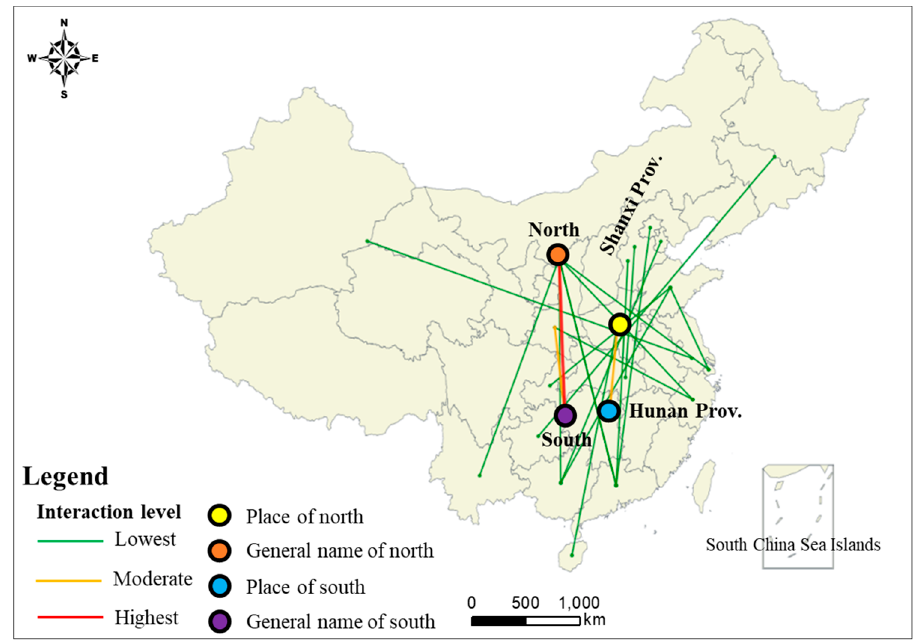
Figure 5. Emotion flow map of people from the north and south of China.